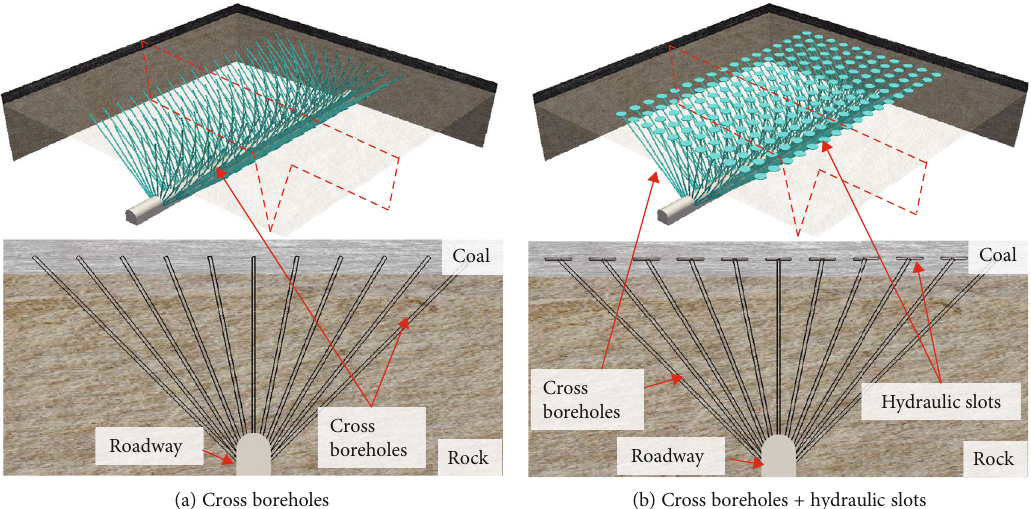
Figure 1: Illustration of methane extraction by (a) dense cross boreholes and (b) cross boreholes + hydraulic